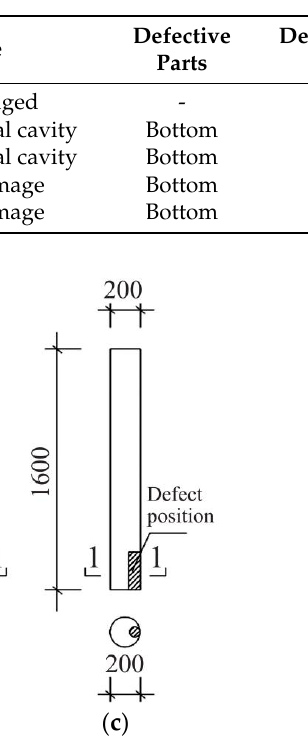
Table 1. Design parameters of reduced scale specimen.